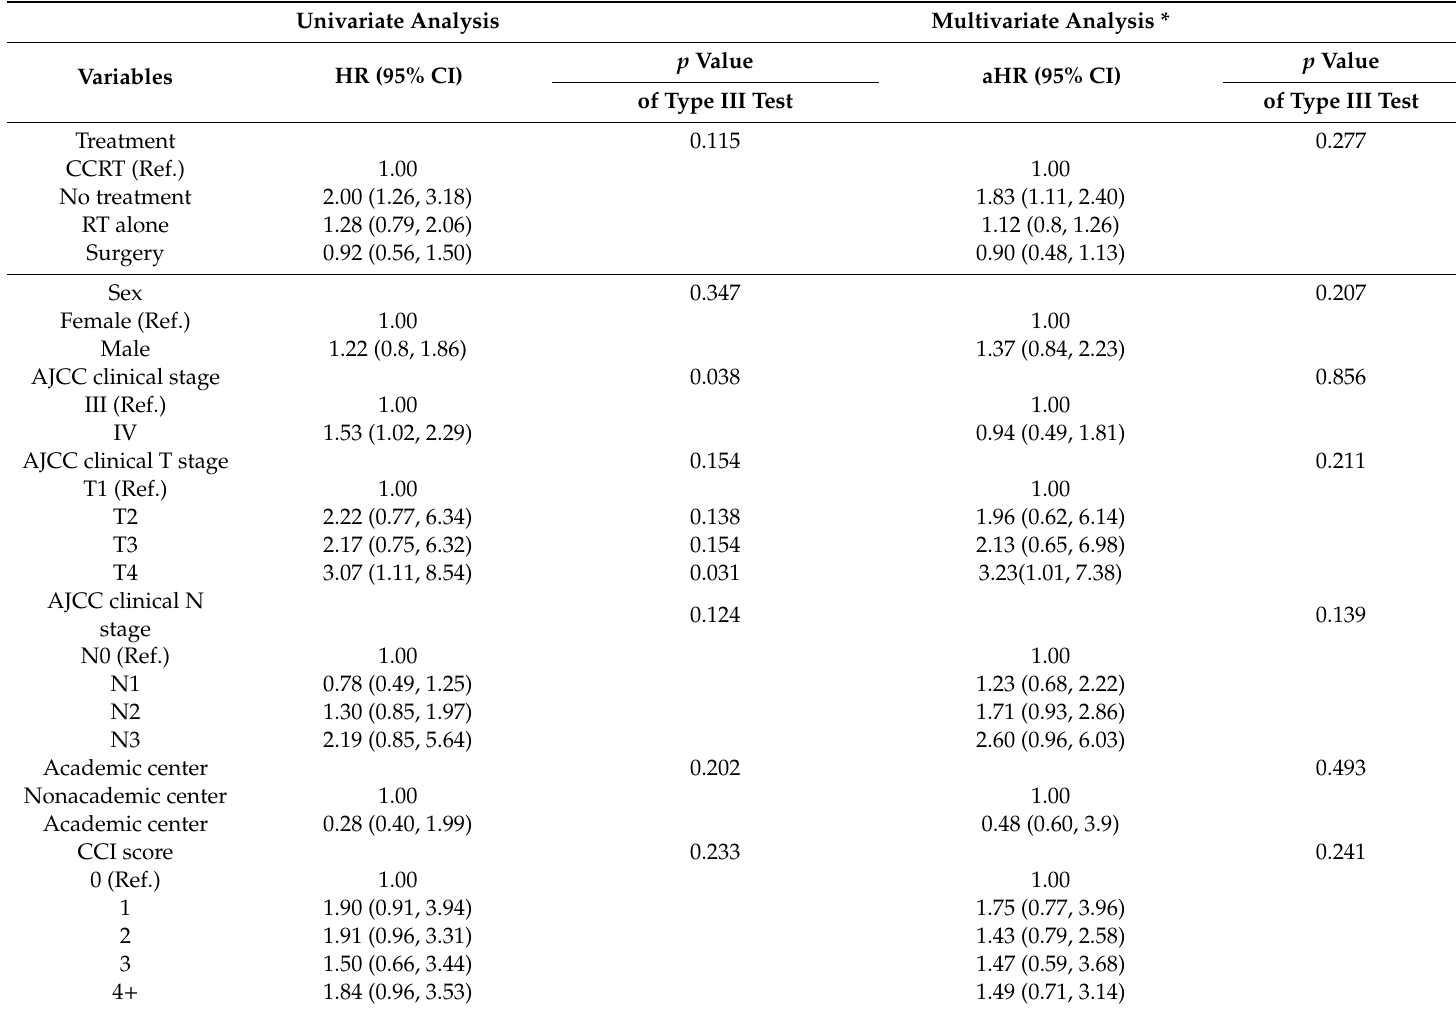
Table 4. Cox Proportional Hazards Model for Mortality Risk in the Oldest Patients Aged ≥ 81 years with Locally Advanced Oral Cavity Squamous Cell